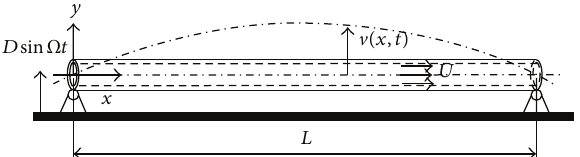
Figure 1: A horizontal pipe conveying fluid with external harmonic